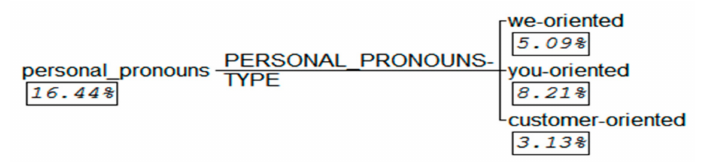
Figure 6. Use of personal pronouns in the